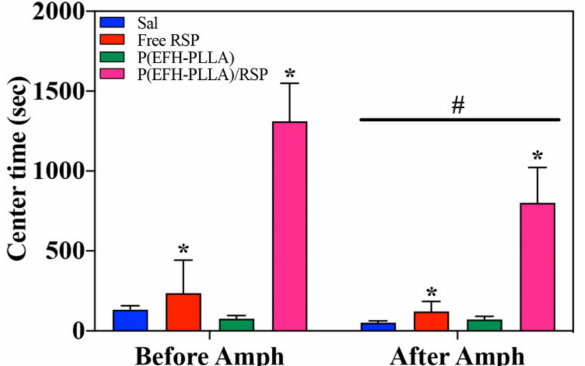
Figure 9. Center time analysis using ANOVA of open field test with hollow and drug-loaded NP treatment 0–30 min prior to amphetamine administration and 30–60 post amphetamine uptake. Asterisks (*) denote statistical significance versus saline and the hashtag (#) signifies the e ff ect of amphetamine